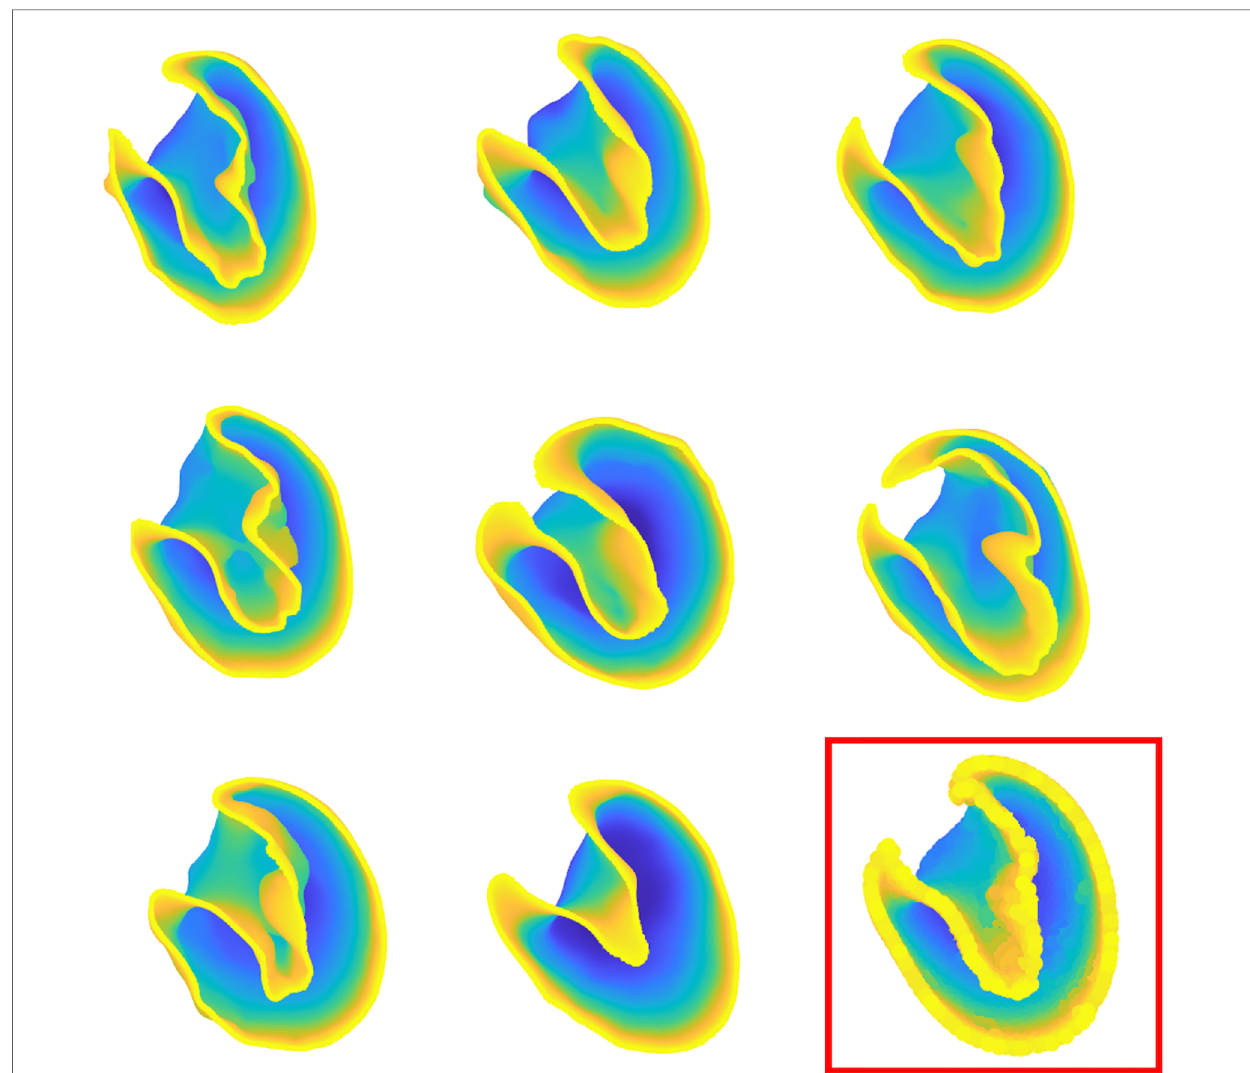
FIGURE 4 Some of 66 patient-speci fi c left ventricle shapes after processing and preliminary operations. The template shape is indicated in the bottom right of the fi